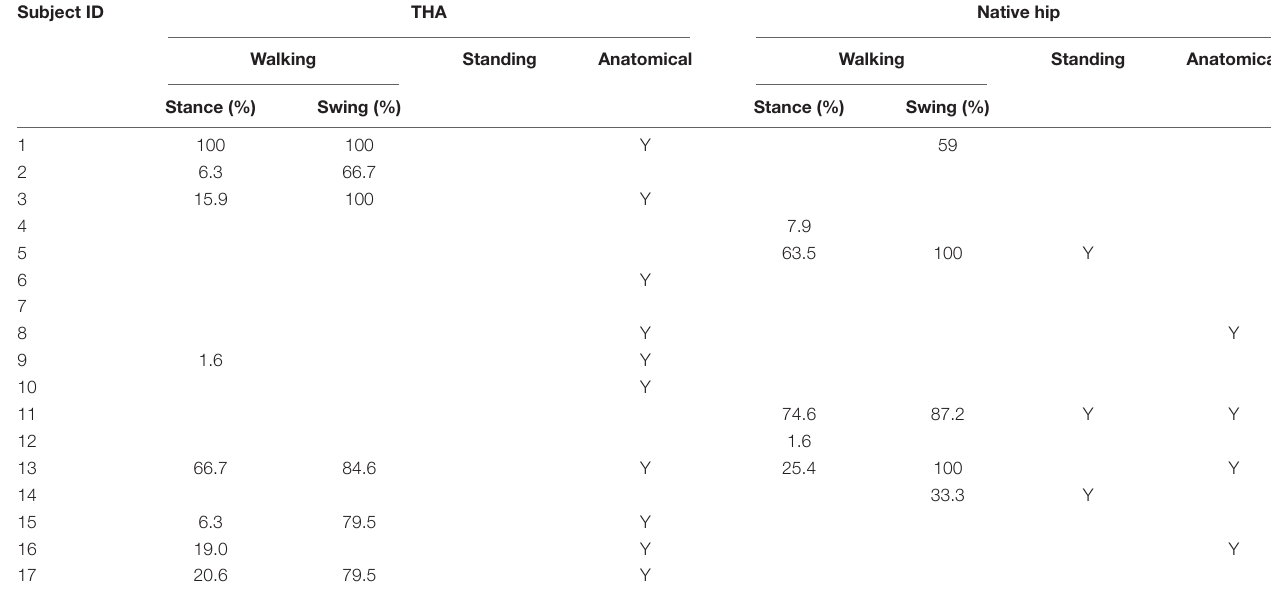
TABLE 3 | Duration of stance phase and gait cycle when THAs and native hips stayed in the Lewinnek safe zone were calculated for each individual patient. Subject ID THA Native hip Walking Standing Anatomical Walking Standing Anatomical